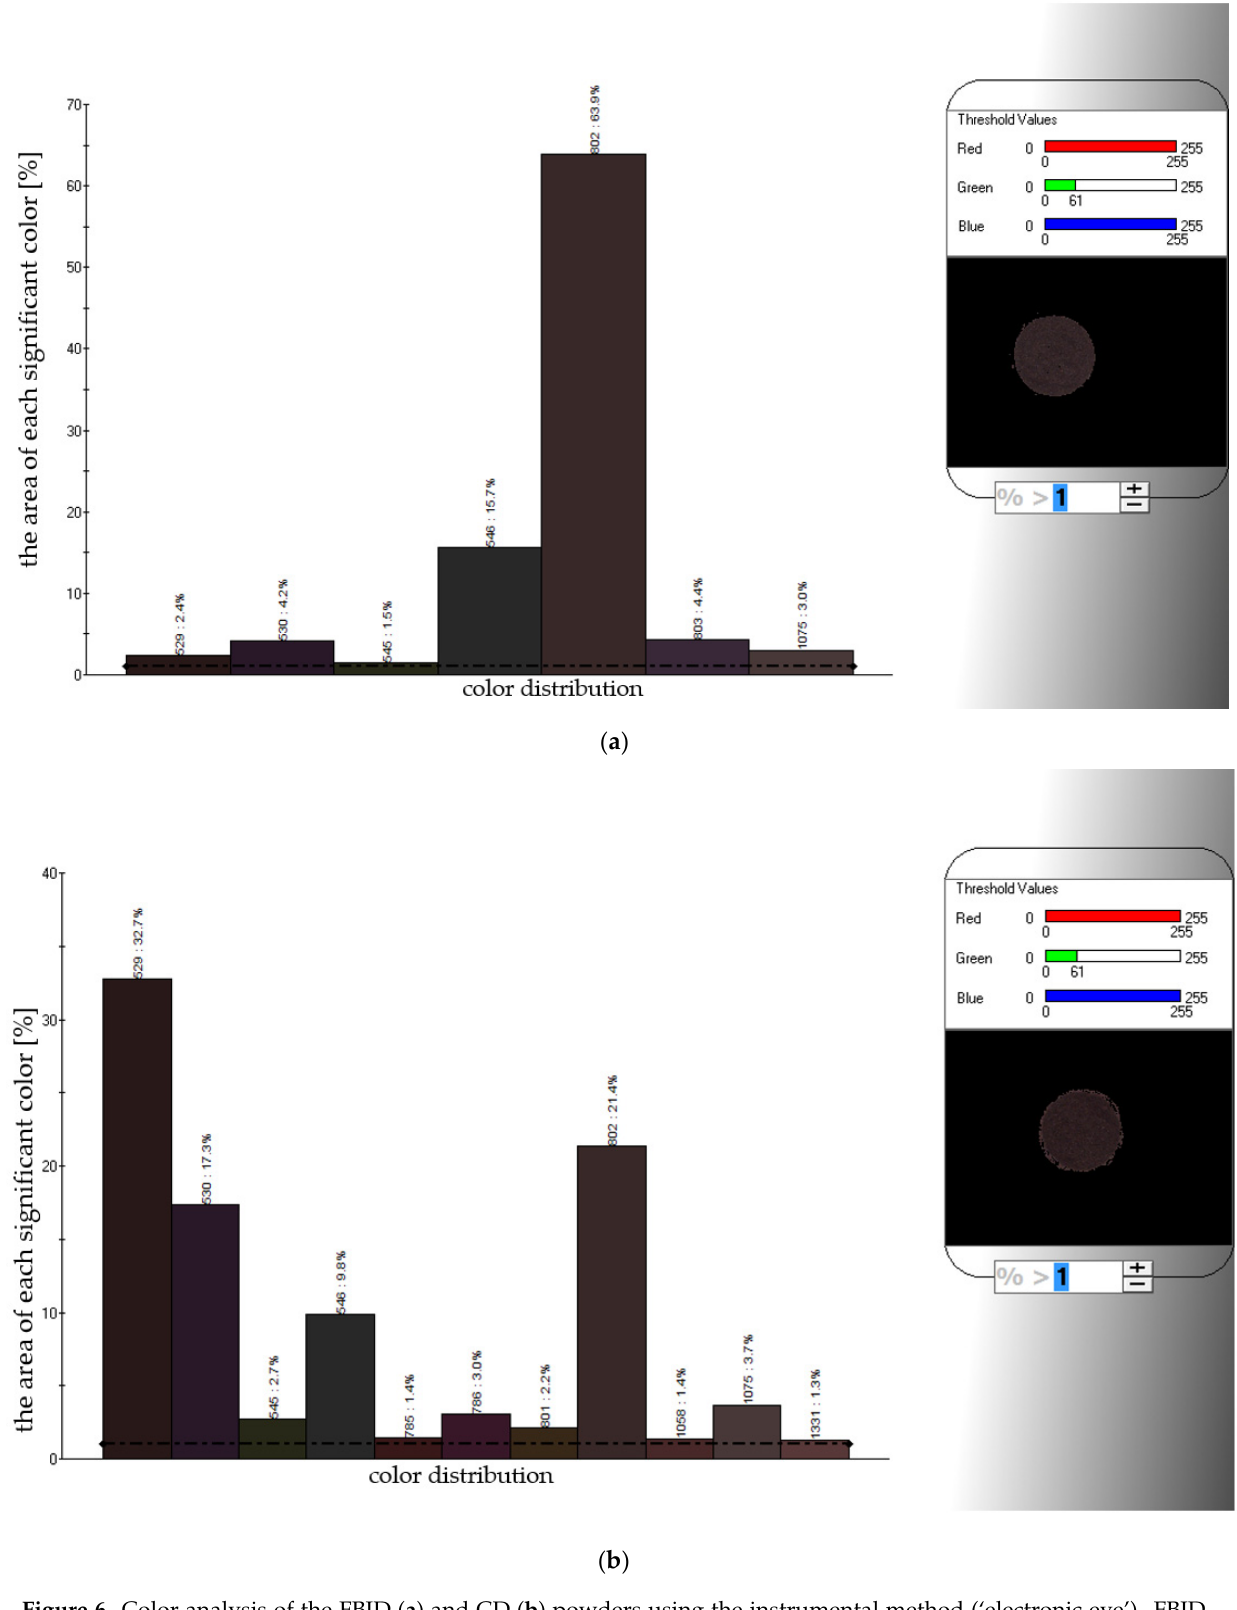
Figure 6. Color analysis of the FBJD ( a ) and CD ( b ) powders using the instrumental method (‘electronic eye’). FBJD— fluidized-bed jet milling and drying; CD—convective drying. The dashed line marks the area (>1%) from which each significant color was taken into account. Table 5. Color parameters in CIE L*a*b* and RGB space obtained for chokeberry FBJD and CD powders using the instrumental method (‘electronic eye’).